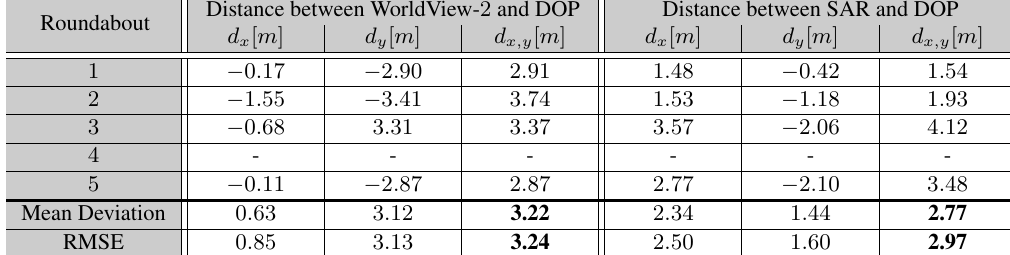
Table 4. The distances d x and d y in x - and y -direction, the Euclidean distances d x,y , between the detected roundabout centers of the WorldView- 2 and reference image, respectively the SAR and reference image, the mean deviation and, the root mean square error (RMSE). The x -direction corresponds to east and the y -direction to